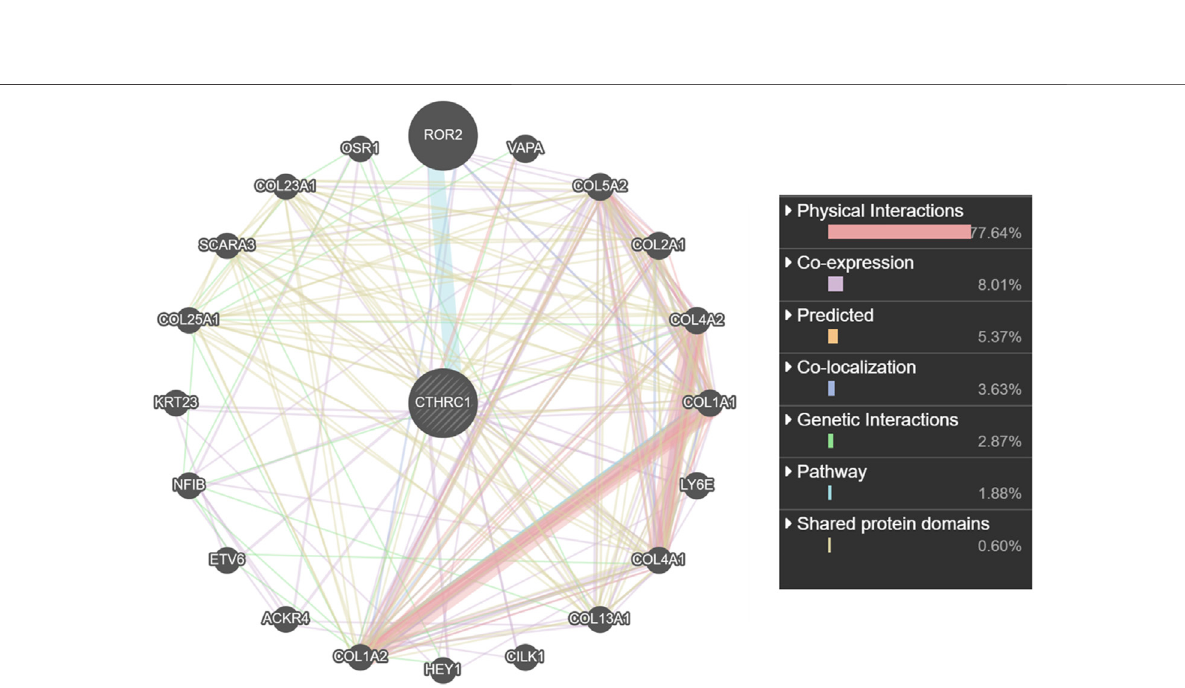
Frontiers in Molecular Biosciences |